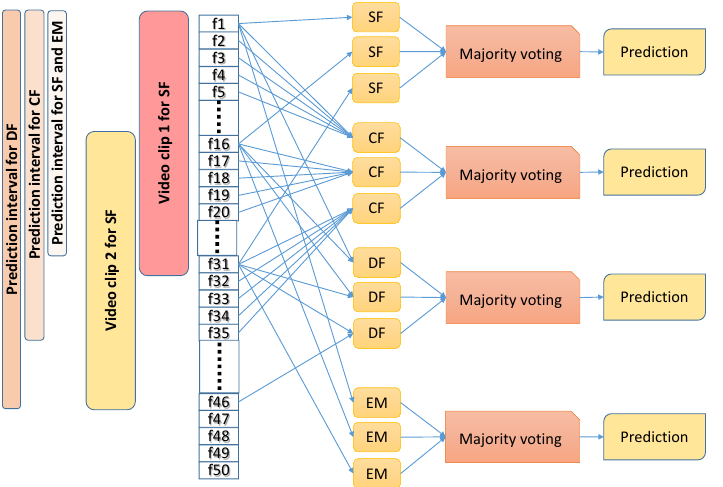
Figure 7. Schemes used for testing the proposed models: all models are tested on overlapping video clips. Within each video clip, three predictions are made and majority voting is applied to derive the prediction for this video clip.